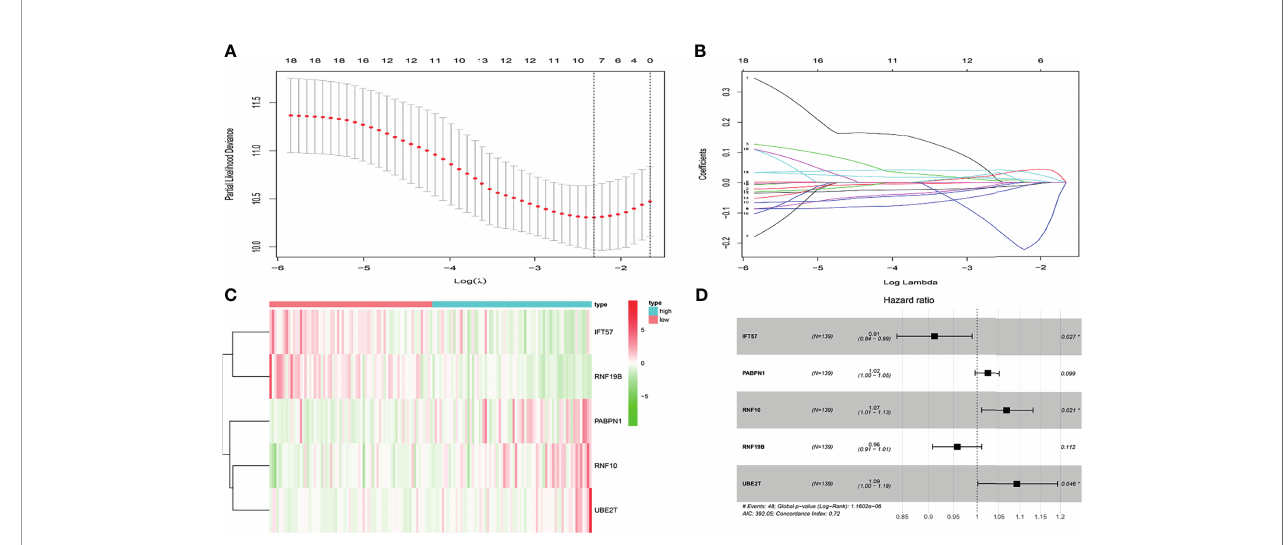
FIGURE 2 | (A, B) After univariate logistic regression, the LASSO regression algorithm was performed to further identify the most valuable prognostic hypoxia- related genes with non-zero regression coef fi cient. (C) The heatmap of hypoxia-related prognostic genes expression level. (D) The high-risk hypoxia-related prognostic factors selected by multivariate Cox